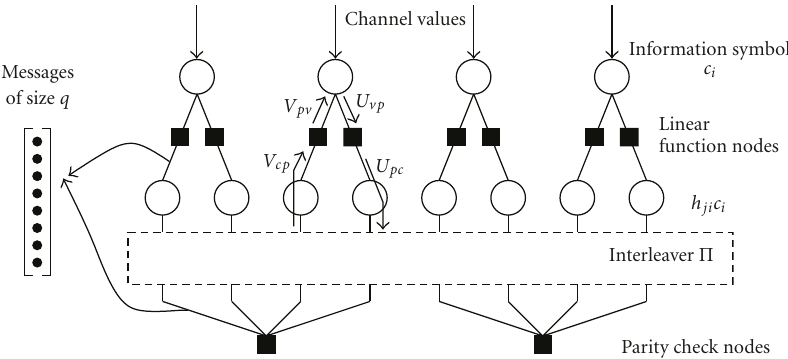
Figure 3: Tanner graph of a nonbinary LDPC code defined over a finite group G ( q